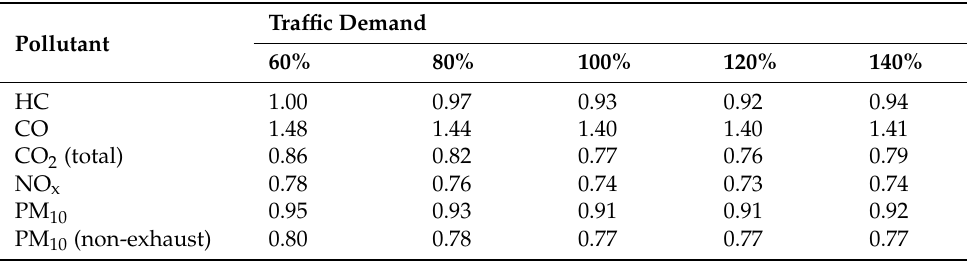
Table 4. Change in the emissions per km (link based vs. OD-pair based calculation) (correct street type).